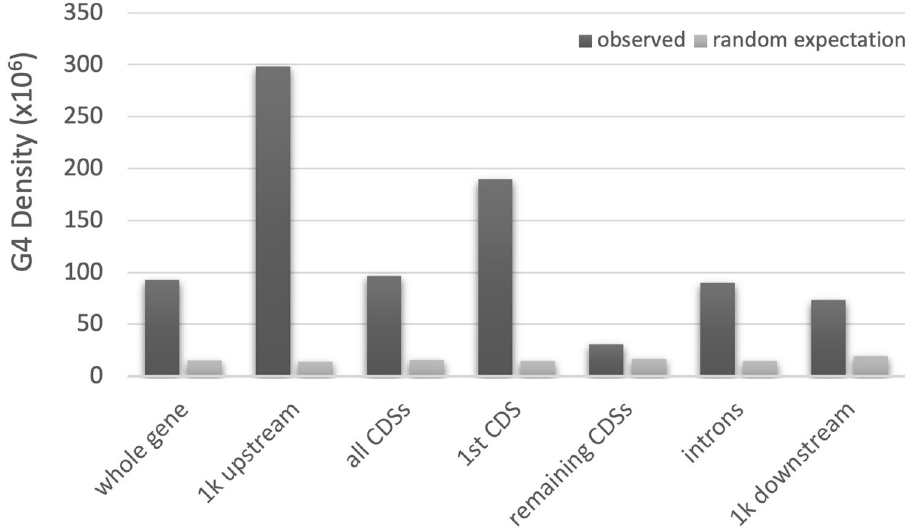
Figure 1. G4 density distribution across gene structural elements. G4 density was calculated as the total number of G4 motifs overlapping with each target region, per Mb. Target regions include 1k (1000 bp) upstream of the gene start codon, 1k downstream, CDSs, introns, and the whole